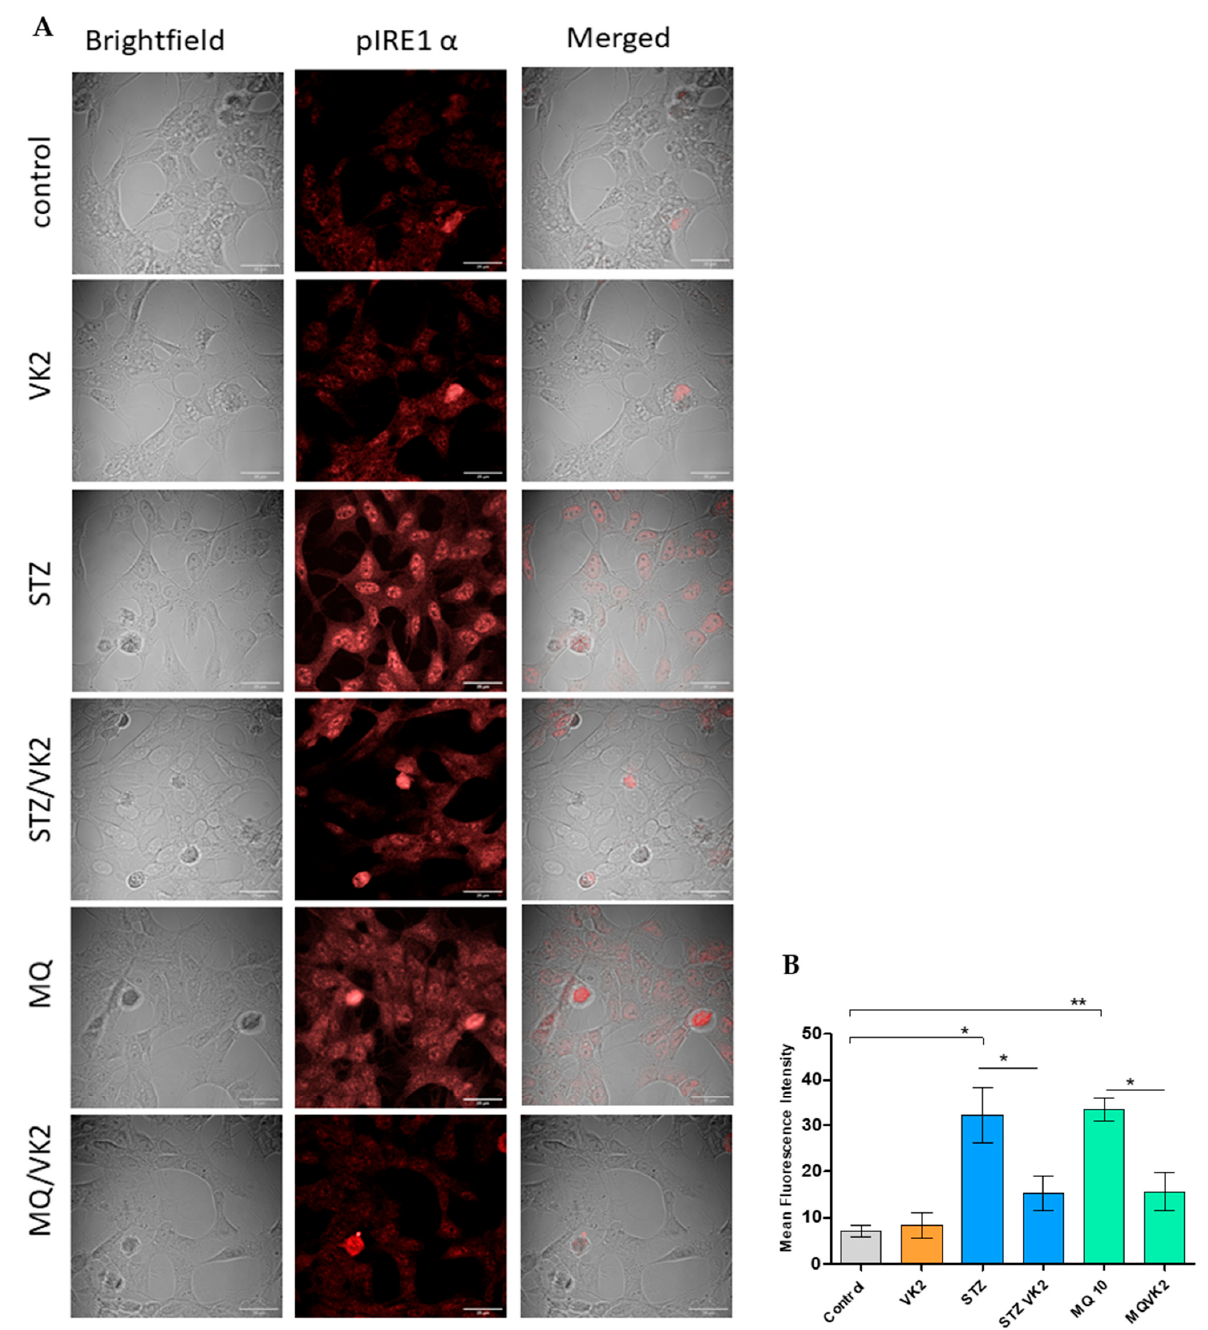
Figure 6. Determination of p-IRE1 α expression by immunofluorescence staining using confocal microscopy. ( A ) Images of human SH-SY5Y neuroblastoma cells were taken after streptozotocin and menadione (MQ) exposure and post-treatment with vitamin K2. All images were taken with a 63 × oil objective. Images were taken in brightfield and Texas red modes, where AF568 (red staining) represents p-IRE1 α . Further merged mages were used to observe the differences among the control, only VK2, streptozotocin (2.5 mM) and its post-treatment with vitamin K2 (50 µ M); menadione (10 µ M) and its post-treatment with vitamin K2 (50 µ M). ( B ) Representative graphs of the mean fluorescence intensity from three different fields of view using ImageJ software. The data are presented as mean ± SEM. Statistical analysis was performed using Student’s t -test and differences with p -value ≤ 0.05 were designated as significant. * p < 0.05 and ** p < 0.01 denote significant differences compared to the control and between the treatment groups. [STZ—streptozotocin; VK2—vitamin K2; STZ/VK2—post-treatment of streptozotocin (2.5 mM)-treated cells with vitamin K2 (50 µ M); MQ—enamdione; MQ/VK2— post-treatment of menadione (10 µ M)-treated cells with vitamin K2 (50 µ